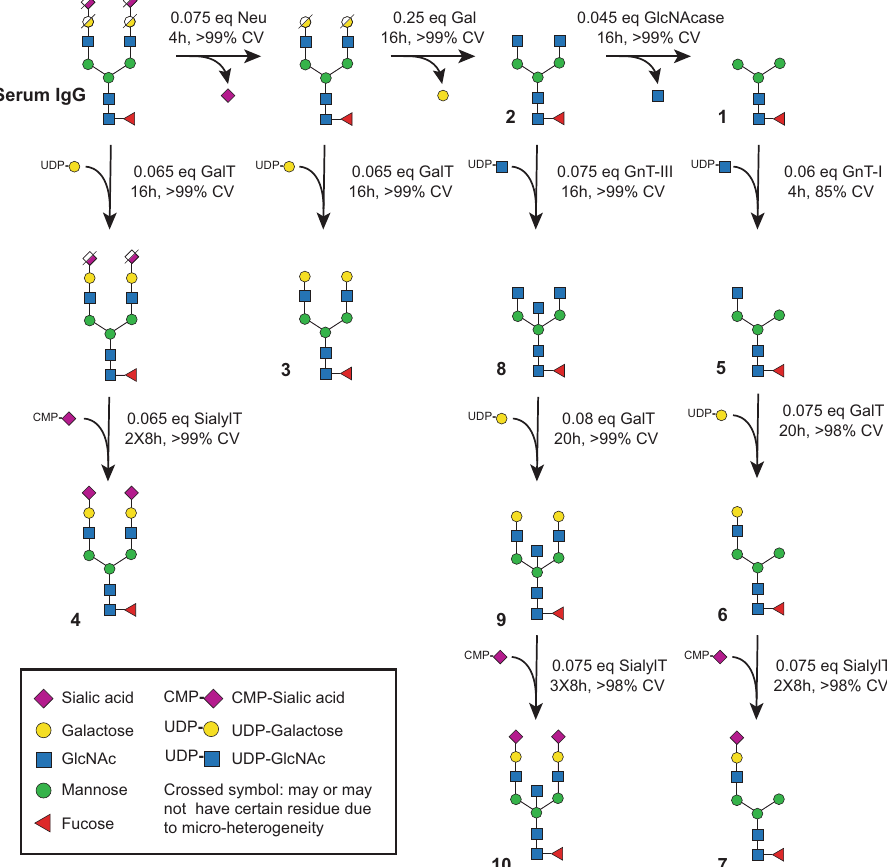
Fig. 4 Scheme of SPGR routes investigated in this work. Human serum IgG contains a ~5% defucosylated population and a ~10% bisecting population. For simplicity, these two populations are not shown in the scheme. The conversion (CV) ratio was calculated based on the consumption of substrate glycan species. 10 mg IgG was used to initiate the reactions with observed product recovery ranging from 75% to 80%. Reaction condition 10 mg/ml human serum IgG (66.67 μ M); 1 mM sugar-donor. Neu neuraminidase, Gal galactosidase, GlcNAc N -acetyl-glucosamine, GlcNAcase N -acetylglucosaminidase, SialylT sialyltransferase, GalT galactosyltransferase, GnT N -acetyl-glucosaminyltransferase, UDP Uridine-diphosphate, CMP